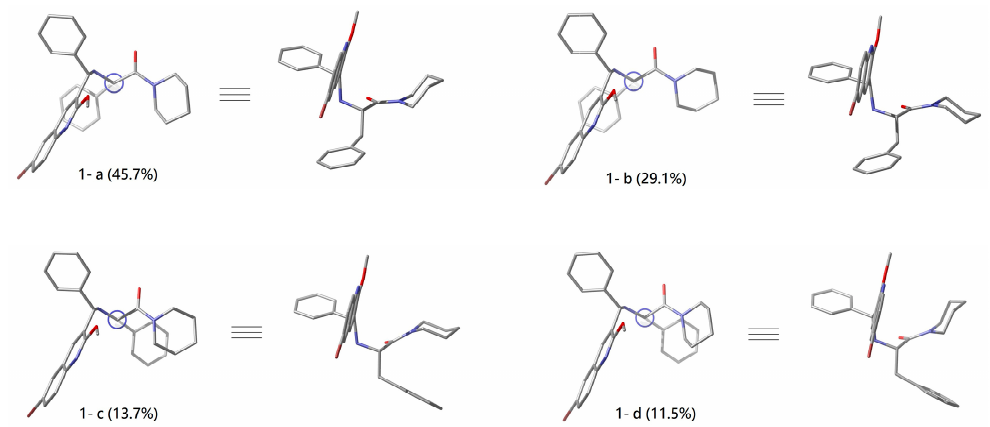
Figure 1. Relative stable conformers of 1 . All conformers are shown as “Newman projections” viewed along the C10-C13 bond axis. Table 1. Gibbs free energies ( G ), relative Gibbs free energies ( ∆ G ) a and Boltzmann weighting factor ( P %) b of compound 1 conformers by using the DFT/B3LYP/6-311++G(2d,p) method. Conf. G Conf.